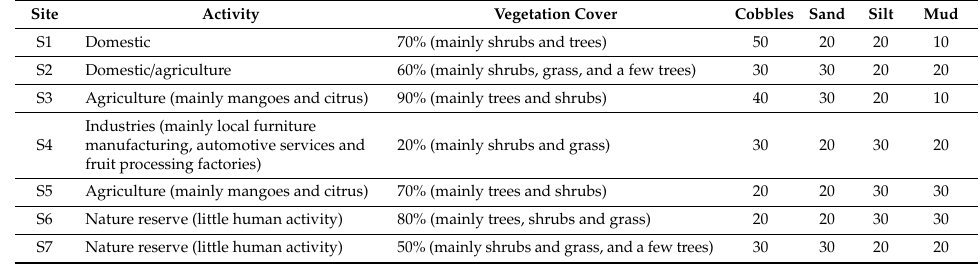
Table 1. Location, description of activities, vegetation cover and substrate type